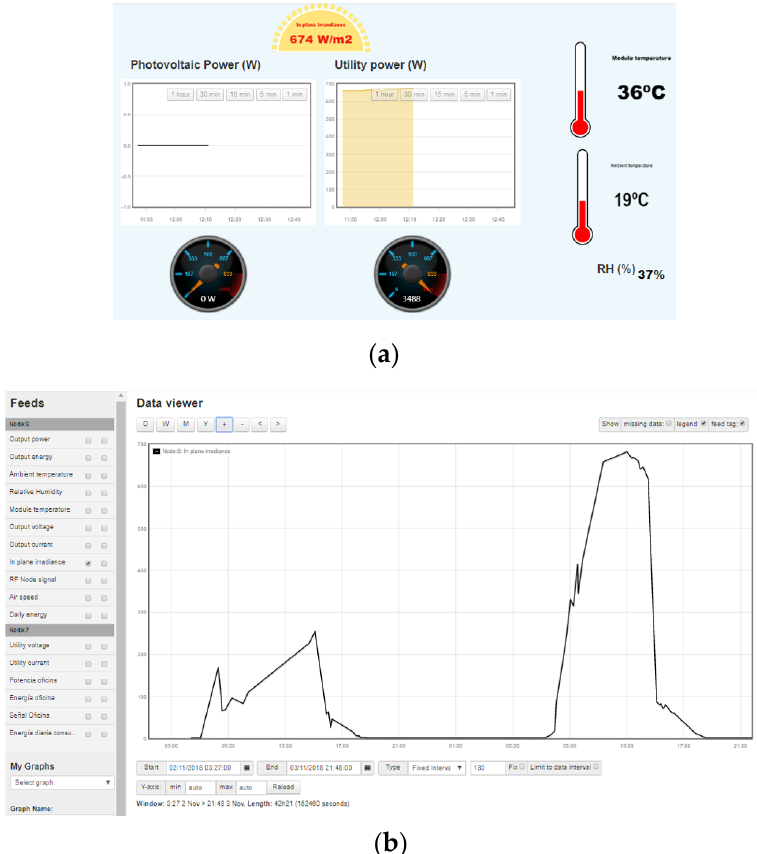
Figure 7. Customized Emoncs web application. Front-end example: ( a ) dashboard panel; and ( b ) PV data